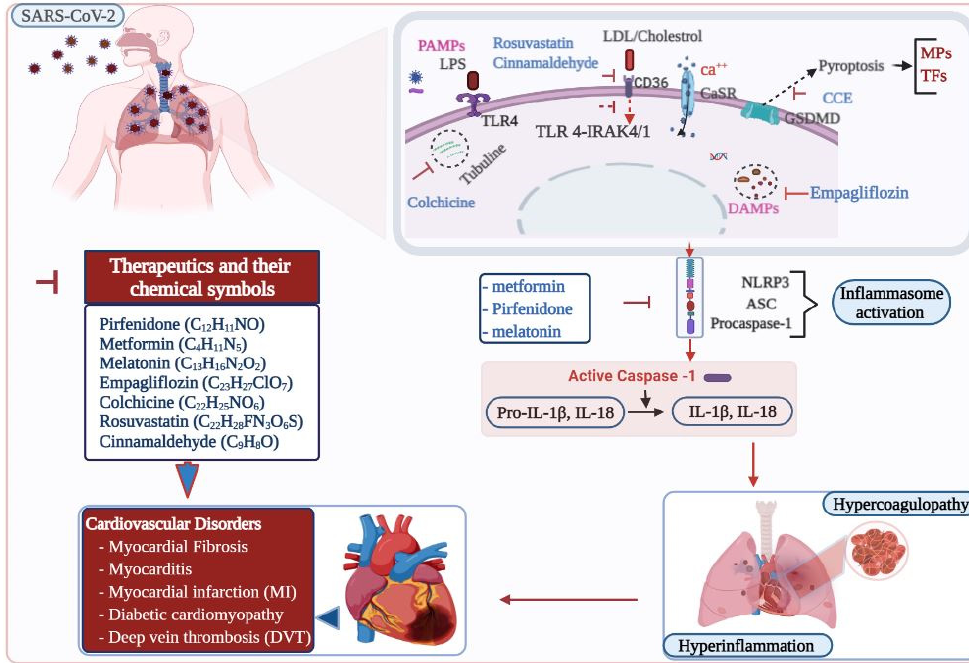
Figure 2. Therapeutic targets in inflammasome induced cardiovascular disorders in COVID-19. SARS-CoV-2, the causative agent for COVID-19, causes pulmonary infection. Inflammasomes are activated in SARS-CoV-2 infected patients. Activation of NLRP3 inflammasome results in hyperinflammation and hypercoagulopathy, which ultimately leads to cardiovascular complications in COVID-19. Various therapeutic compounds are indicated in inhibiting the pathways leading to the inflammasome activation and preventing cardiovascular risks. ASC, apoptosis-associated speck-like protein containing a caspase recruitment domain; Ca, calcium; CaSR, calcium-sensing receptor, CCE, cholecalciferol cholesterol emulsion; CD, cluster of differentiation; DAMPs, damage-associated molecular patterns; GSDMD, gasdermin D; HIF-1 α , hypoxia inducible factor one alpha; IL-1 β , Interleukin 1 beta; IL-18, Interleukin 18; IRAK, interleukin-1 receptor-associated kinase; LDL, low density lipoprotein; LPS, lipopolysaccharide; MPs, micro-particles; NLRP3, nucleotide-binding oligomerization domain, leucine-rich repeat, and pyrin domain containing 3 protein; PAMPs, pathogen-associated molecular patterns; SARS-CoV-2, severe acute respiratory syndrome coronavirus two; TFs, tissue factors; TLR 4, toll-like receptor.